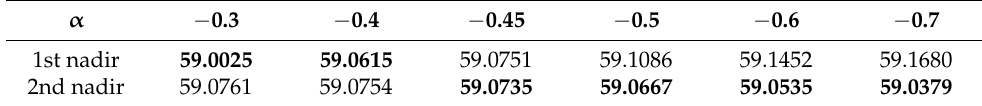
Table 3. First and second frequency nadir according to RoCoF constant α .